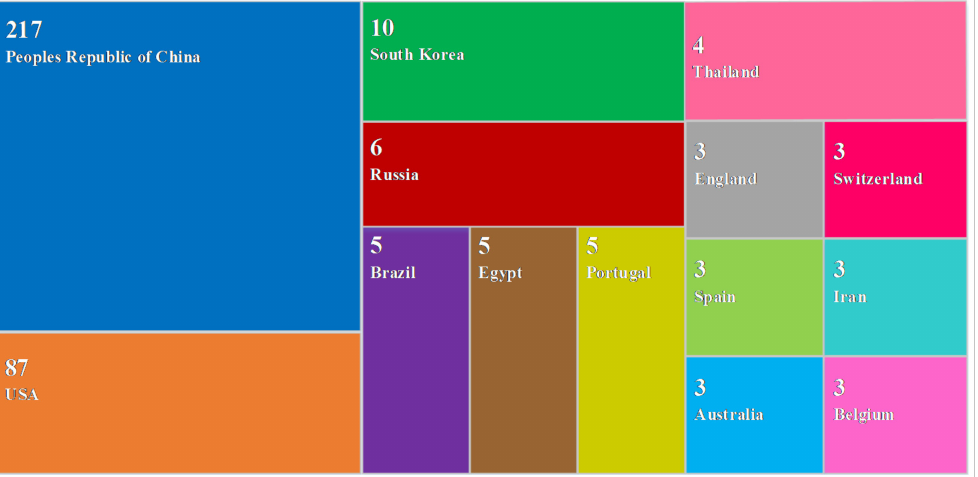
Figure 4. Top 10 publishers in search of related literature by key words.